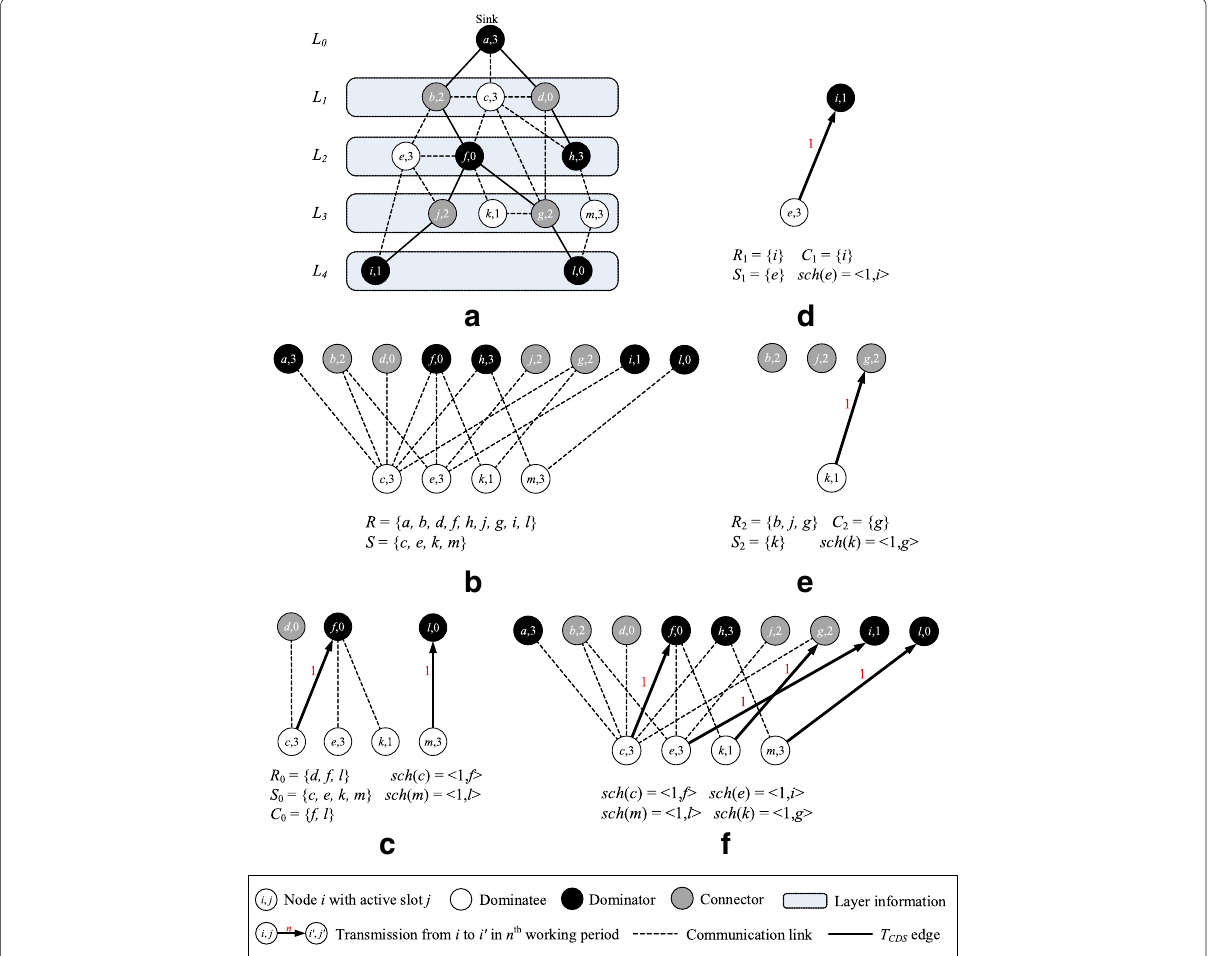
Fig. 3 An example of dominatee scheduling. a Layered network structure. b Separating nodes into receiving and sending sets. c Scheduling at active slot 0, working period 1. d Scheduling at active slot 1, working period 1. e Scheduling at active slot 2, working period 1. f Transmissions in the same working